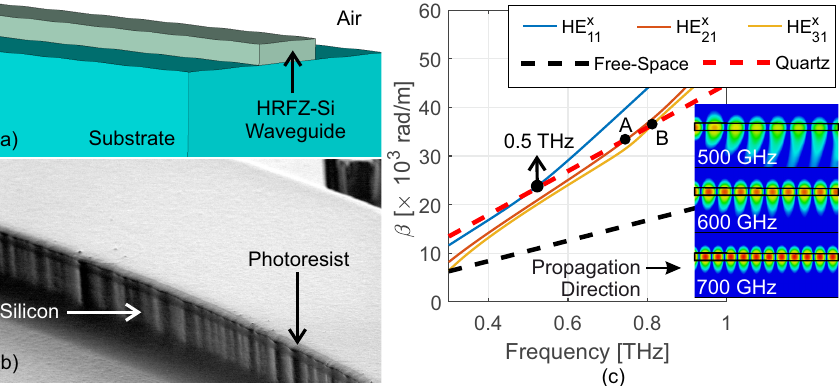
Figure 1. ( a ) Topology of the designed dielectric waveguides. ( b ) Microscopic image of an etched waveguide. The photoresist mask is visible on top of the waveguides. Side-wall irregularities are caused due to the pixelated nature of the lithographic mask. ( c ) Simulated values of the propagation constant ( β ) of the first 3 modes. Points A (0.75 THz) and B (0.81 THz) show the lower cut-off frequencies for HE x and HE x modes, respectively. Simulation snapshots in the inset shows waves 21 31 leaking into the substrate for f THz ≤ 0.5 THz. The black rectangular outline represents the HRFZ-Si waveguide. The dielectric below is quartz ( n = 2.13), the dielectric above is air ( n =